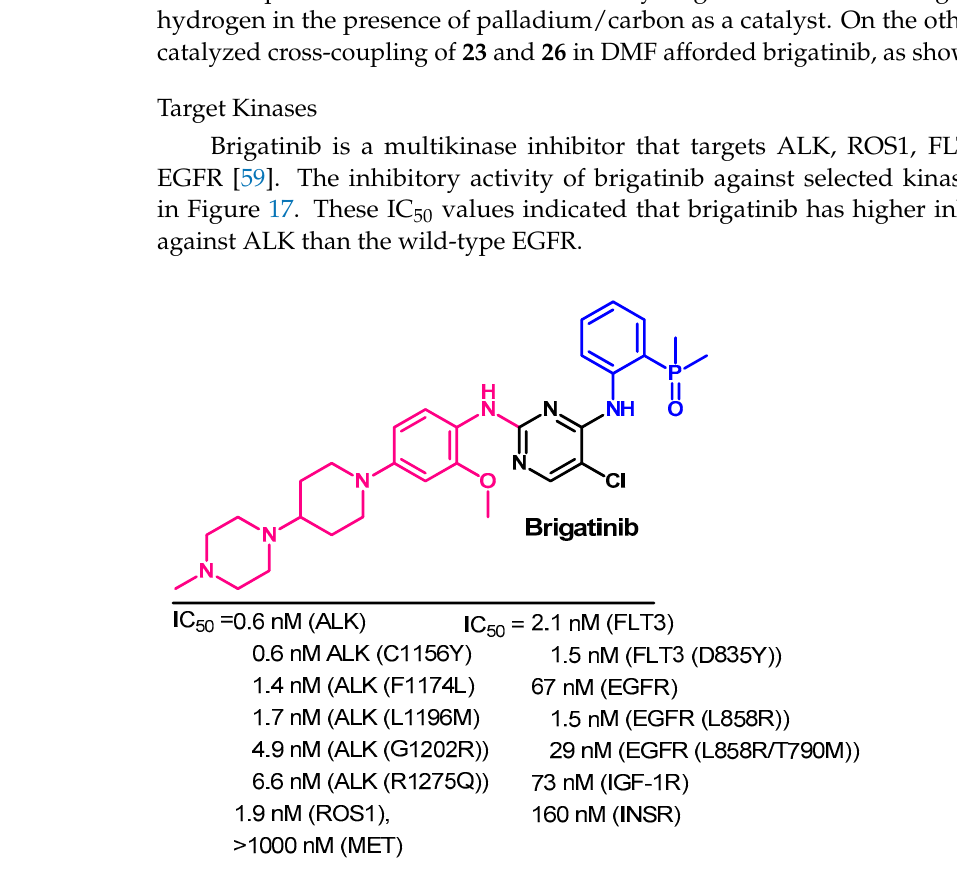
Figure 17. Kinase inhibitory activities of brigatinib.